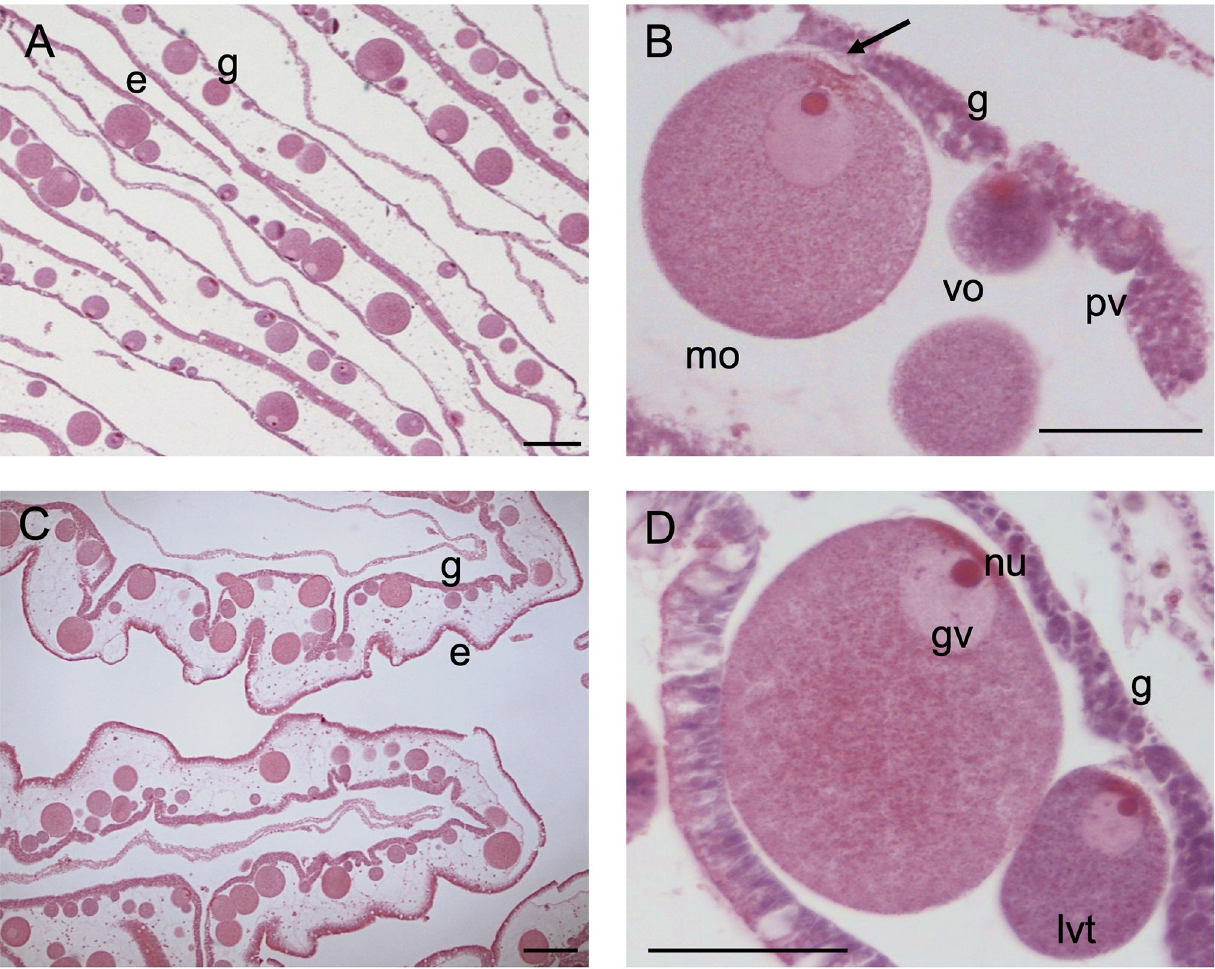
Fig 1. Histological section of a female gonad. (A, C) Ovary (B, D) Development of oocytes. g gastrodermis, e endodermis, pv pre-vitellogenic oocyte embedded within gastrodermis, vo vitellogenic oocyte, lvt late-vitellogenic oocyte mo mature oocyte, arrow residual linkage with trophocytes (paraovular body), nu nucleolus, gv germinal vesicle. Scale bars: A, C = 100 μ m; B, D = 50 μ m. Based on diameters, oocytes were grouped in 4 size classes: < 20 μ m (oocytes in pre-vitello- (mature oocytes) Spermatogenesis occurs inside follicles, which are distributed evenly in the male gonads (Fig 2A). The process starts from male germ cells (spermatogonia) that going through multiple mitosis give rise to the sperm follicles that have mostly a round/ovoidal shape. Spermatogonia will then develop into primary spermatocytes which will move inward in the follicle. Through meiosis, secondary spermatocytes will be formed, characterized by a high chromatin quantity. With the second meiosis, secondary spermatocytes will form spermatids that will then develop a flagellum and become spermatozoans (Fig 2B). At the final stage of spermatogenesis, the aboral part of the follicle (facing gastrodermis) will be filled by mature spermatozoan with a visible flagellum, packed in sperm bundles called spermatozeugmata [73] (Fig 2B). At this point, they will be released through a pore in the genital sinus and then in the water column. Once male has spawned, follicles are characterized by free space in the lumen and the